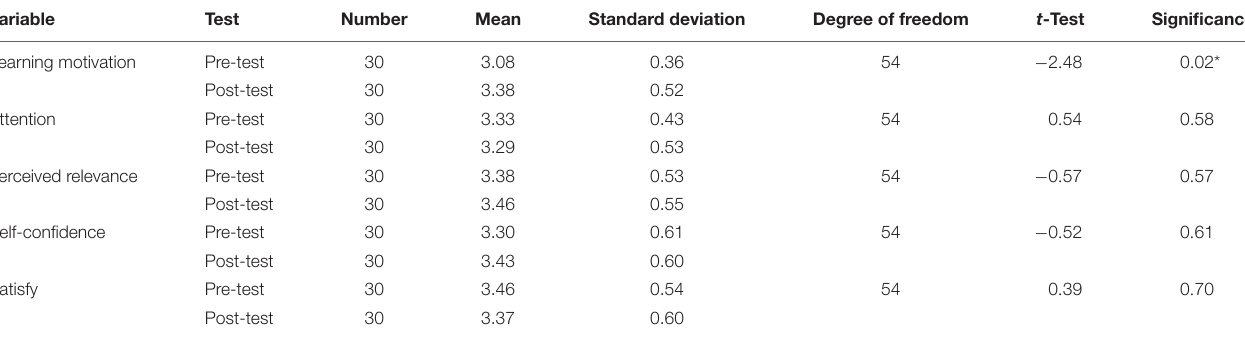
TABLE 9 | Control group ARCS learning motivation scale pre-test and post-test repeated measures t -test analysis.